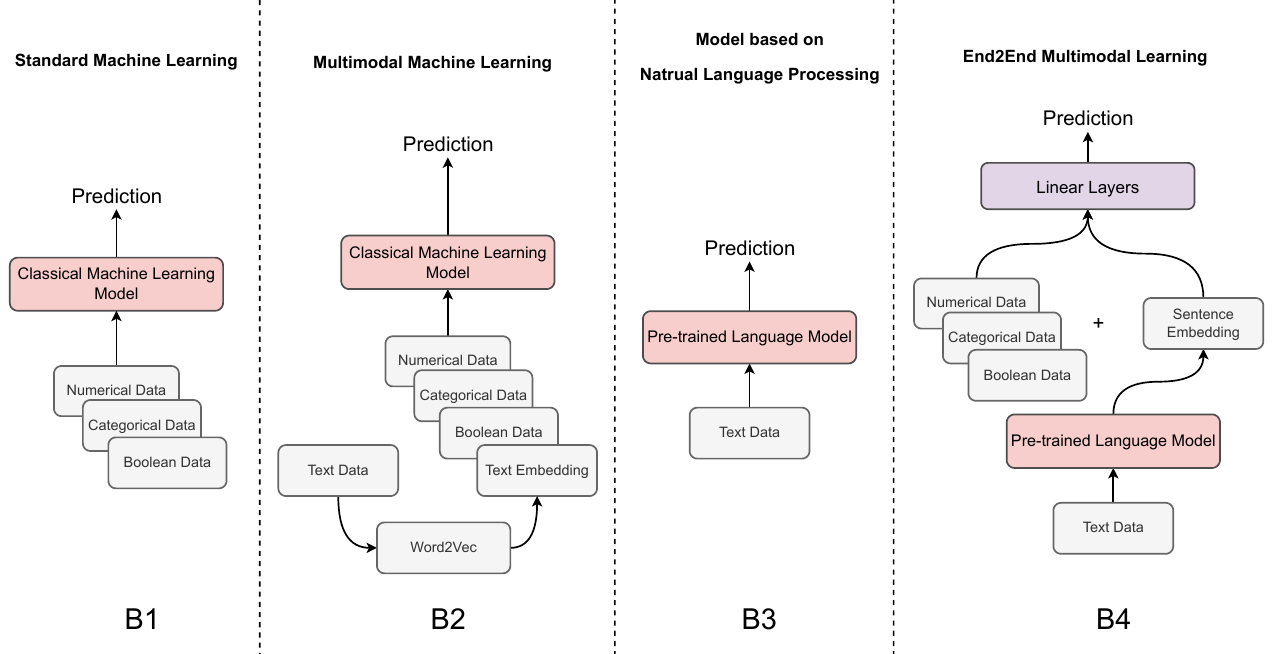
Figure 3. Four baseline alternatives for predicting house prices that incorporate multimodal